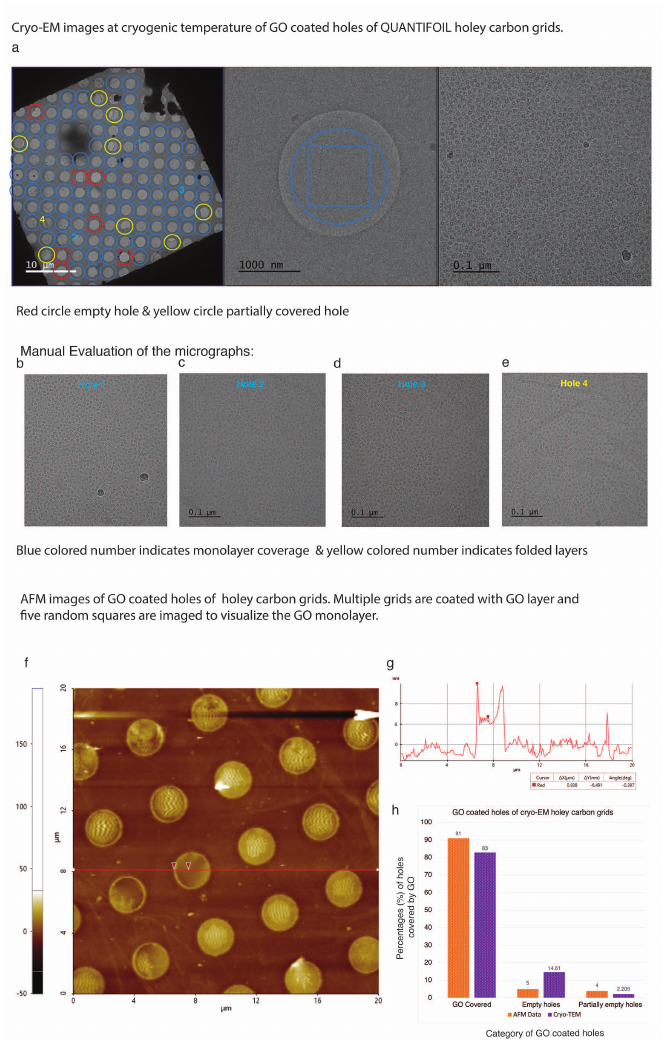
Figure 5. Efficiency of coverage of GO monolayer on holey carbon grids, AFM analysis and SEM, TEM statistical: ( a ) Holey carbon grids are imaged at three different magnifications. At 380 × magnification (left panel), each grid square of the holey carbon grid was screened manually and around 83% of holes of each grid square was covered by GO monolayer. Blue circles show GO monolayer, yellow circles are partially covered and red circles are empty holes. At 4300 × magnification (middle panel), the coverage of holes from each grid square was manually evaluated at higher magnification. Image is collected at 42,200 × magnification. Almost 1500–2000 holes were evaluated manually and almost 83% holes are covered by GO monolayer. ( b – e ) Randomly four holes were selected for imaging in image ( a left panel). Hole1, hole2, hole3 were collected on GO monolayer covered areas (blue circle). Hole4 was collected on partially covered area (yellow circle) ( e ). Hole1, hole2, and hole3 images show that most of the blue holes are covered by GO monolayer. If GO is multilayer is there instead of GO monolayer, multilayer would be visible in high-resolution magnified TEM image, like hole 4 ( e ). Micrographs with folded layer or multilayer are manually screened and removed ( e ). Therefore, the total number of holes covered by GO monolayer are calculated precisely using LatitudeS. Roughly 6 to 14% holes are empty and very few (4–2%) partially empty holes are also observed in this study. ( f ) AFM image of cryo-EM holey carbon grid showing the 91% coverage of GO-methanol-water monolayer. ( g ) Cross section line plot of cryo-EM holey carbon grid showing curve shaped GO decorated holes are extremely suitable to hold biological sample. ( h ) Statistical analysis of GO- methanol-water monolayer coverage over cryo-EM holey carbon grid by AFM analysis, cryo-EM data acquisition software and SEM,